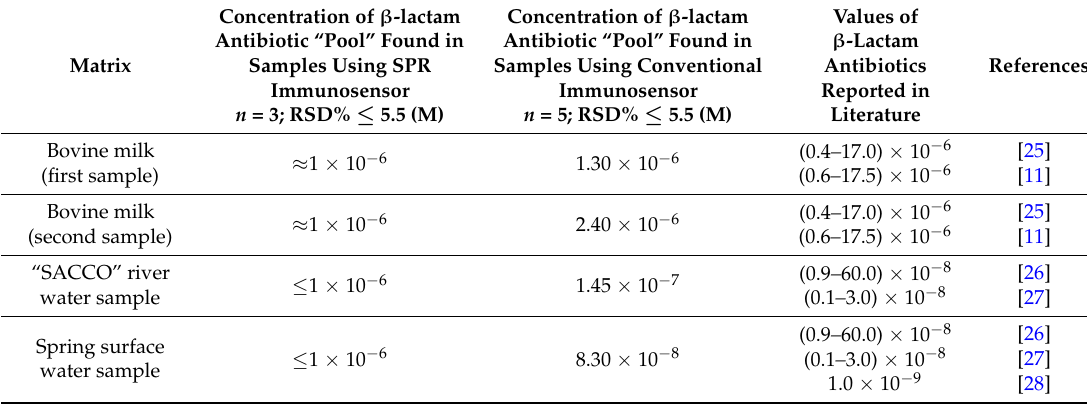
Table 4. “Pool” of β -lactam antibiotic concentration, expressed as M (of ampicillin), found in bovine milk and river and spring surface water samples using the direct SPR immunosensor and the amperometric immunosensor using a competitive